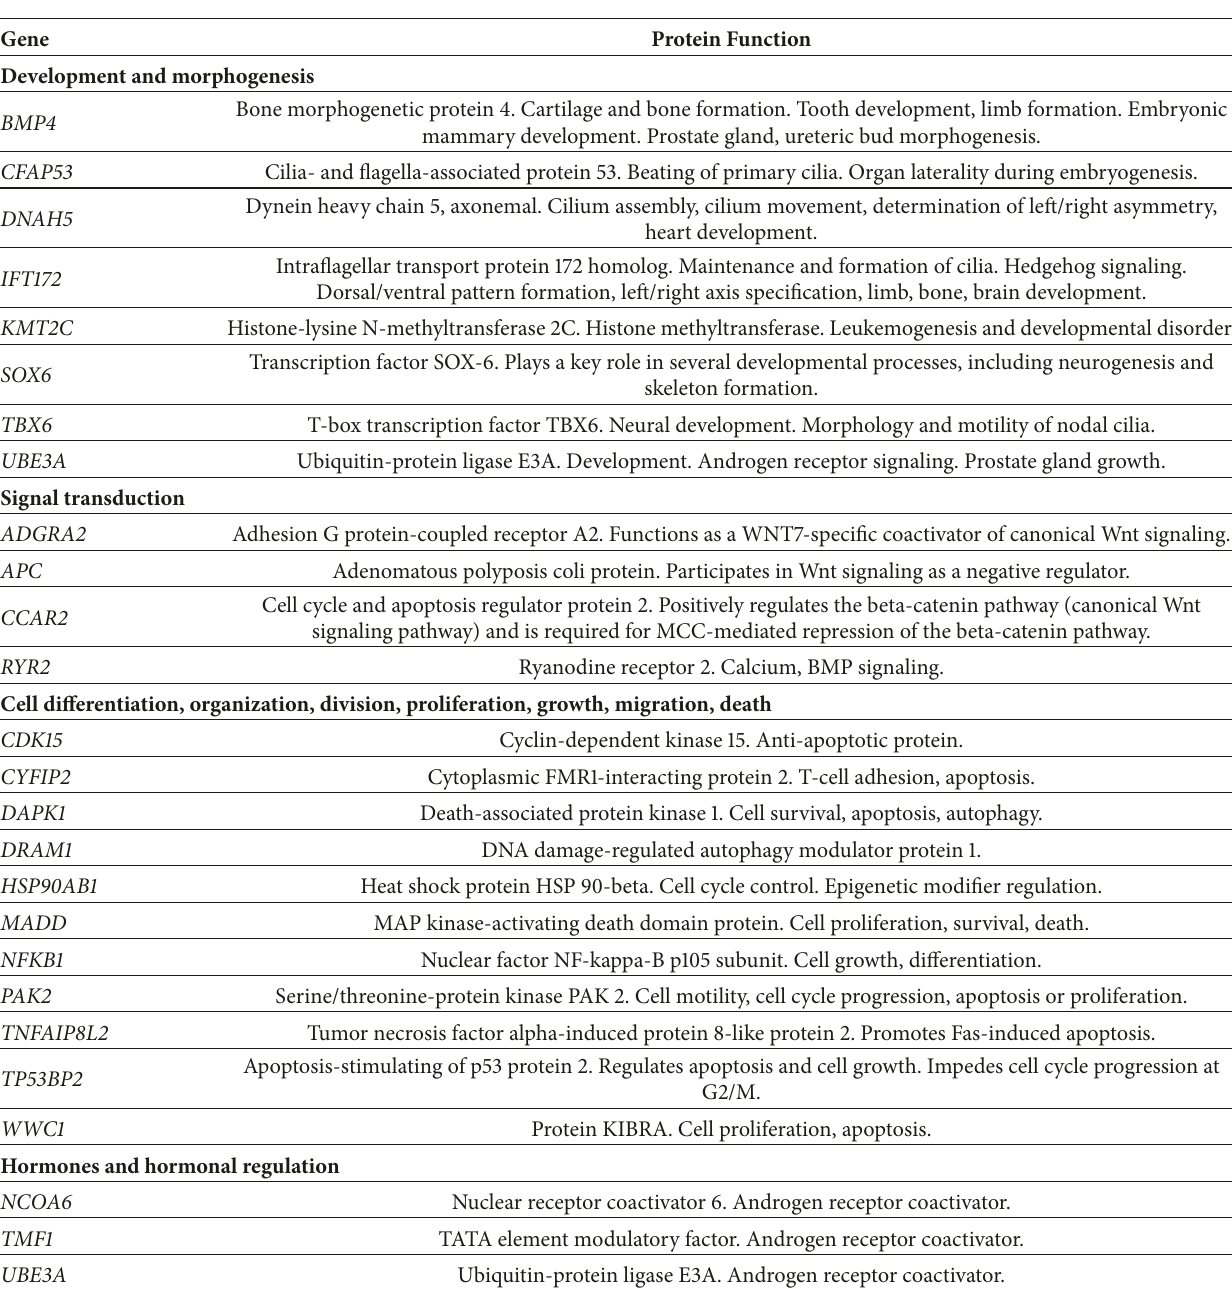
Table 1: Selected genetic variants associated with present diphallia